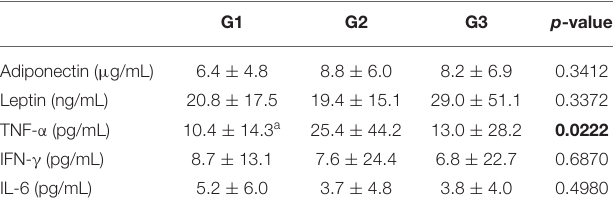
TABLE 6 | Serum levels of adipocytokines and cytokines in men stratified by a group of people living with HIV/AIDS with (G1) and without HALS (G2) and control group